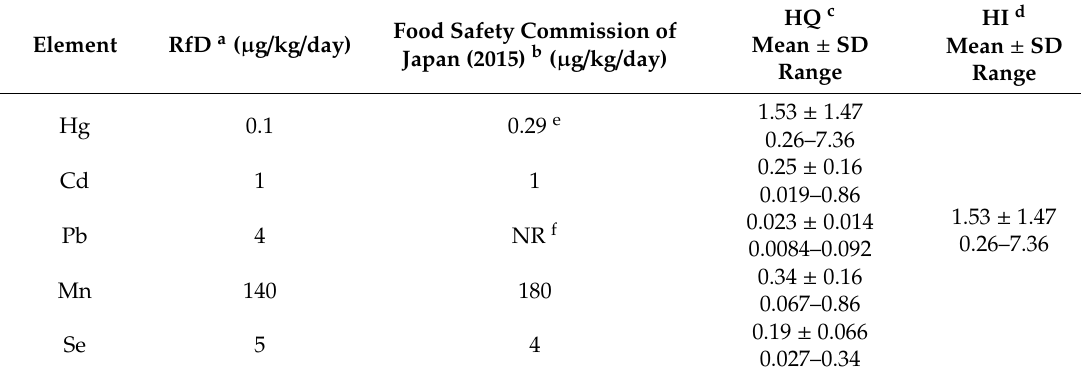
Table 7. Hazard quotient and hazard